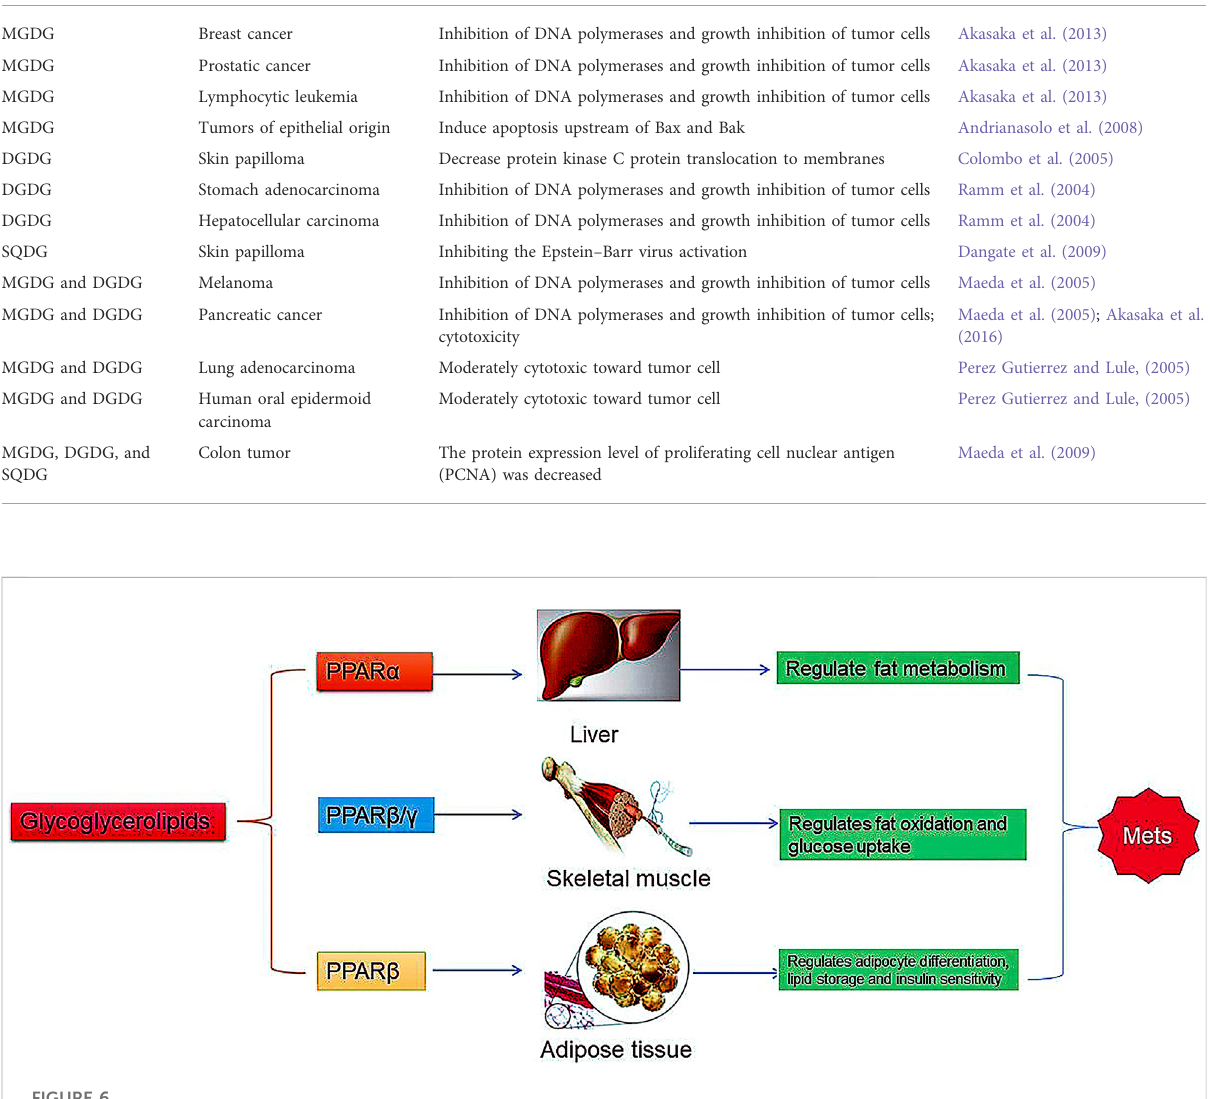
FIGURE 6 Effects of glyceroglycolipids on